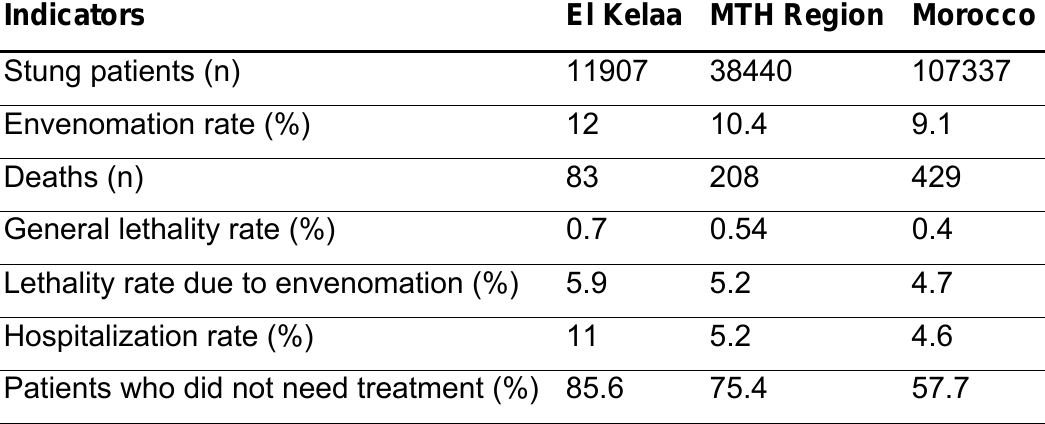
Table 2. Comparison of the evolutionary indicators of scorpion stings among El Kelaa des Sraghna Province, Marrakech Tensift Al Haouz (MTH) region, and Morocco.